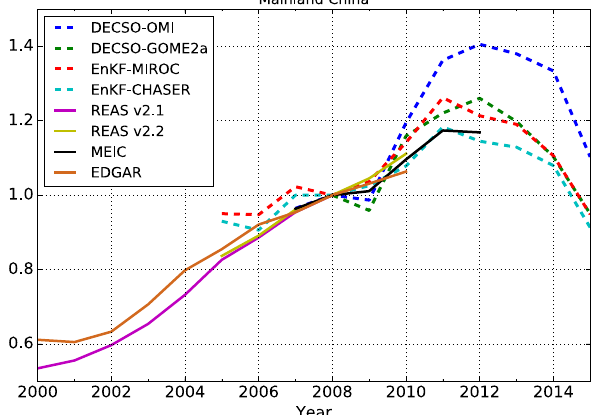
Figure 2. Annual NO x emissions from eight emission inventories over mainland China in the selected domain (Fig. 1).